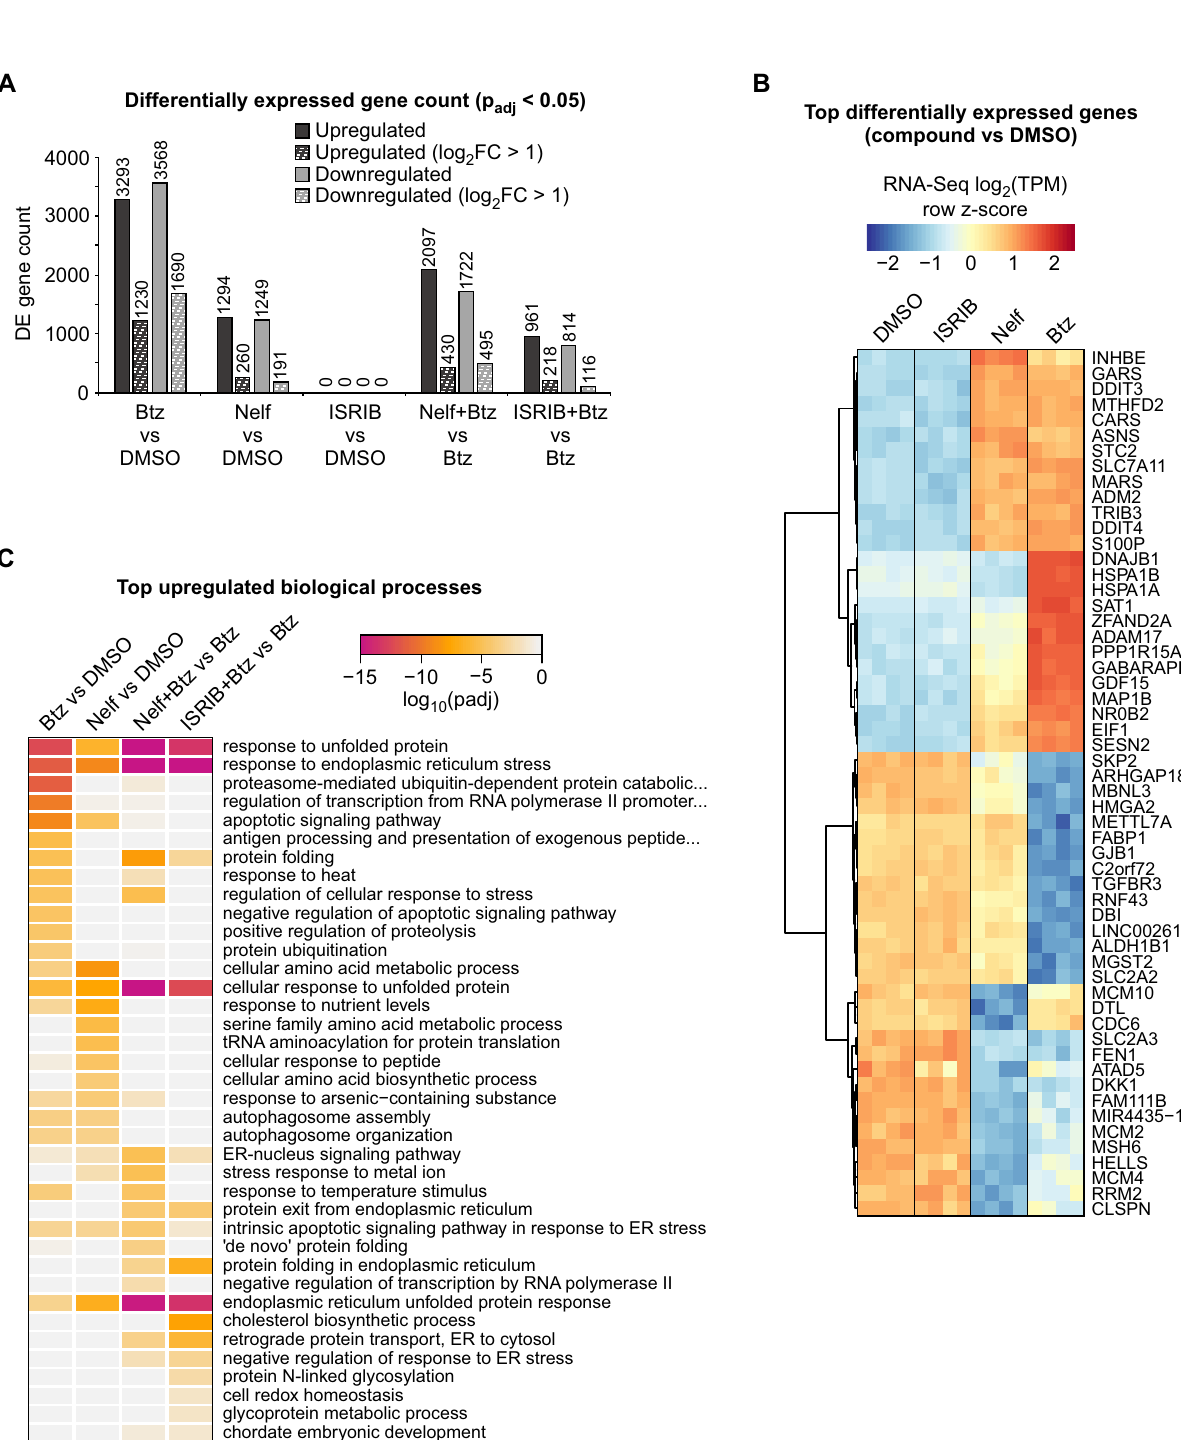
Figure 2. RNA-Seq profiling of bortezomib (Btz) and compounds targeting eIF2 α –ATF4 signaling. HepG2 cells were treated for 10 h with Btz (50 nM), nelfinavir (Nelf; 20 µ M), ISRIB (50 nM) or vehicle (DMSO), as indicated ( n = 4). ( A ) Differentially expressed (DE) gene counts for the indicated pairwise comparisons of gene expression profiles. ( B ) Heatmap depicting the expression levels of most significantly up- and downregulated genes for Btz and Nelf monotreatments. No genes were significantly regulated by ISRIB monotreatment (panel A ). Each column represents an independent library. ( C ) Gene ontology enrichment profiling for the effect of single-compound treatments and the effect of co-treatment with Nelf or ISRIB on the response to Btz. The GO Biological Process database was used, the most significant categories for each query gene list were selected, and the resulting categories were plotted for all the gene expression